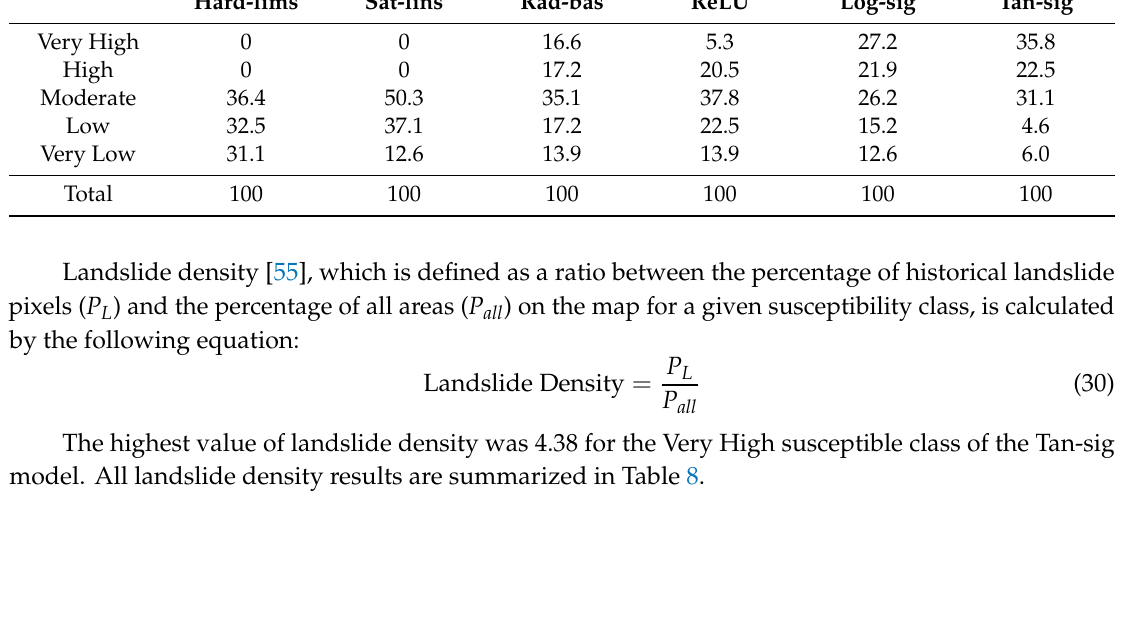
Table 7. Percentages of historical landslides according to susceptibility class (unit: %). Hard-lims Sat-lins Rad-bas ReLU Log-sig Tan-sig Very High 0 0 High 0 0